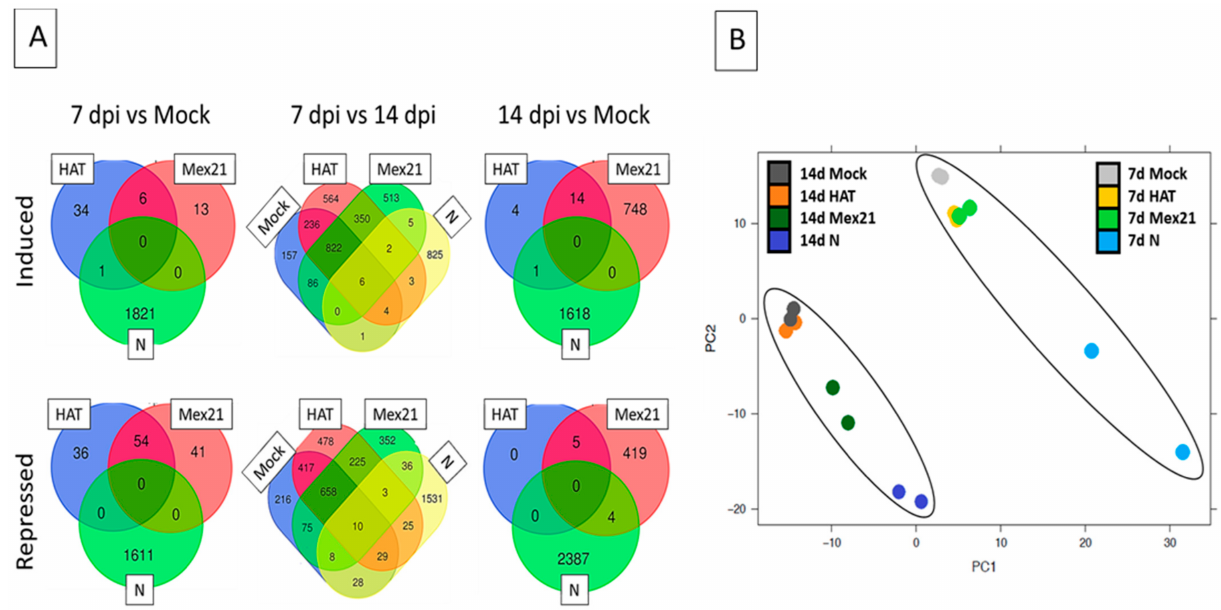
Figure 3. Transcriptome analysis reveals distinct patterns of Tobacco etch virus (TEV) gene regulation. ( A ) Venn diagrams indicating the numbers of pepper differentially expressed genes (DEGs) significantly regulated (induced or repressed) by TEV strains HAT, Mex21 or N at 7 or 14 days post-inoculation (dpi) compared to buffer-mock control plants (Mock) or between the same treatment sample at 7 and 14 dpi from RNA-sequencing analysis. Sample treatments are labeled and represented by distinct colors in each diagram using only significantly regulated DEGs with p adj < 0.05. ( B ) Principle components analysis (PCA) of each RNA-sequencing transcript replicate, depicted as ovals, indicates a clustering of samples corresponding to days post-inoculation of sample collection. Changes within each oval appear to coincide with severity of TEV strain compared to buffer-mock control samples as a mix of PC1 and